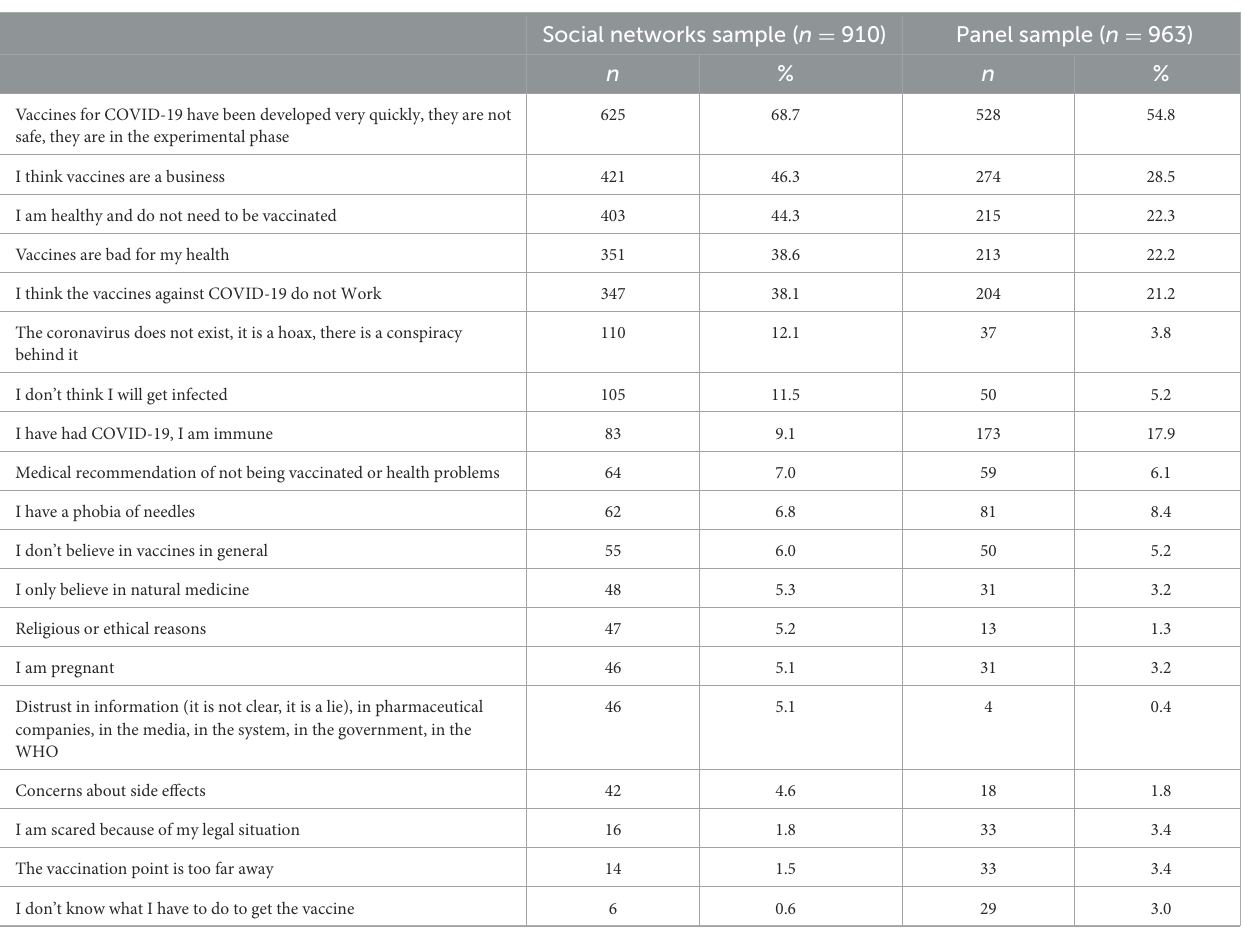
TABLE 2 Reasons for not being vaccinated by sample.